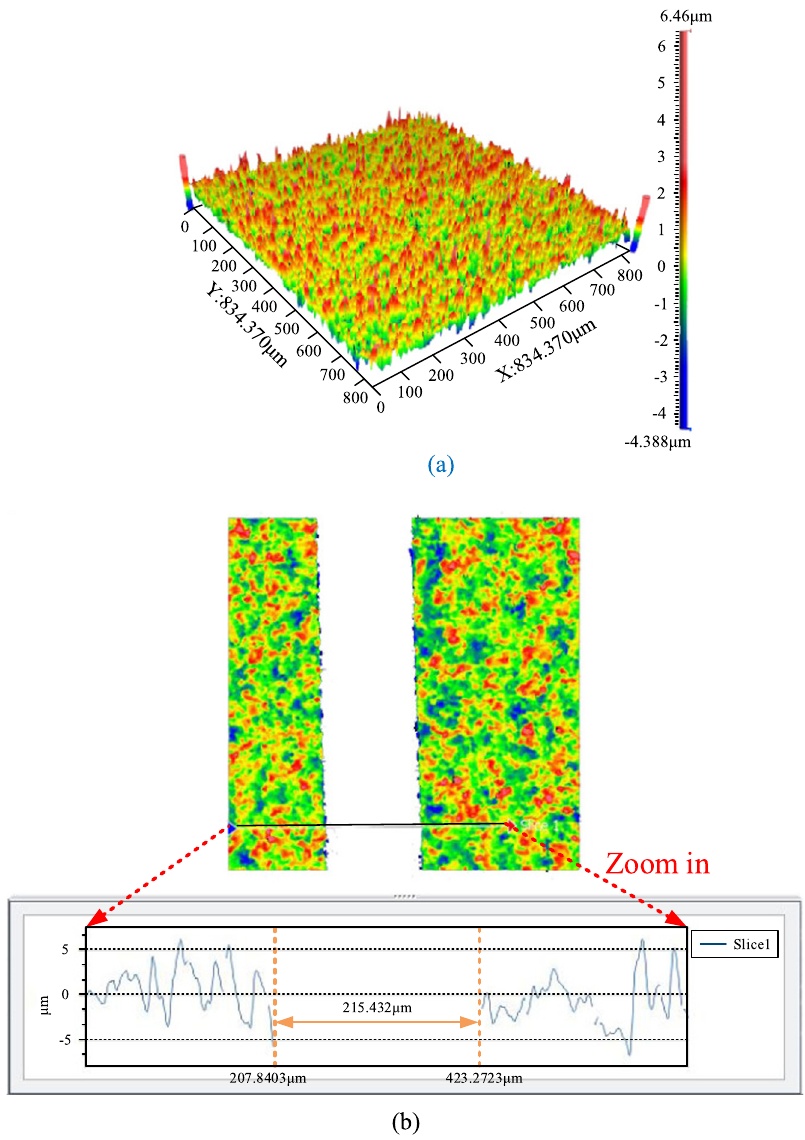
Figure 9: Non - contact measurement of experimental specimens under optimal electrical parameters: ( a ) surface roughness; ( b ) kerf